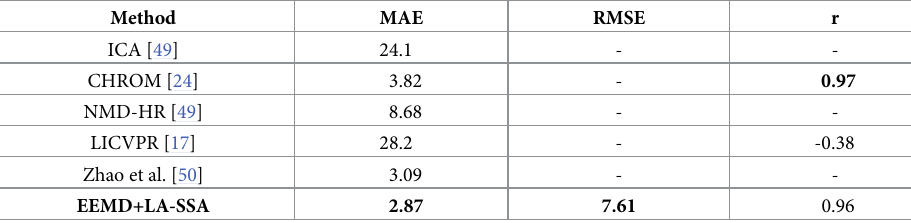
Table 6. Performance of different methods for HR estimation on database PURE.